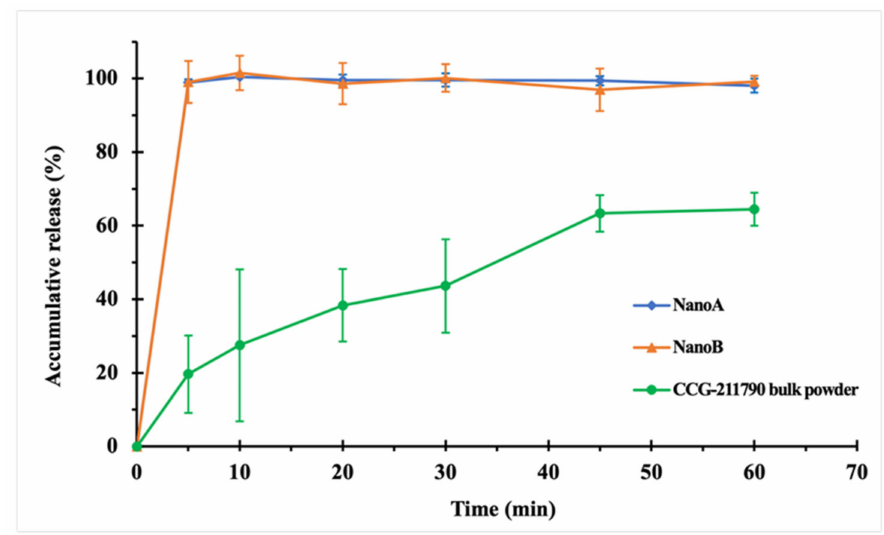
Figure 3. In Vitro dissolution profiles of CCG-211790 bulk powder and NanoA and NanoB sus- pensions in 0.5% SDS solution ( n = 3). There were statistically significant differences between the dissolution rates of NanoA and NanoB and the dissolution rate of CCG-211790 bulk powder ( p < 0.05), while there was no statistical difference between NanoA and NanoB ( p > 0.05).